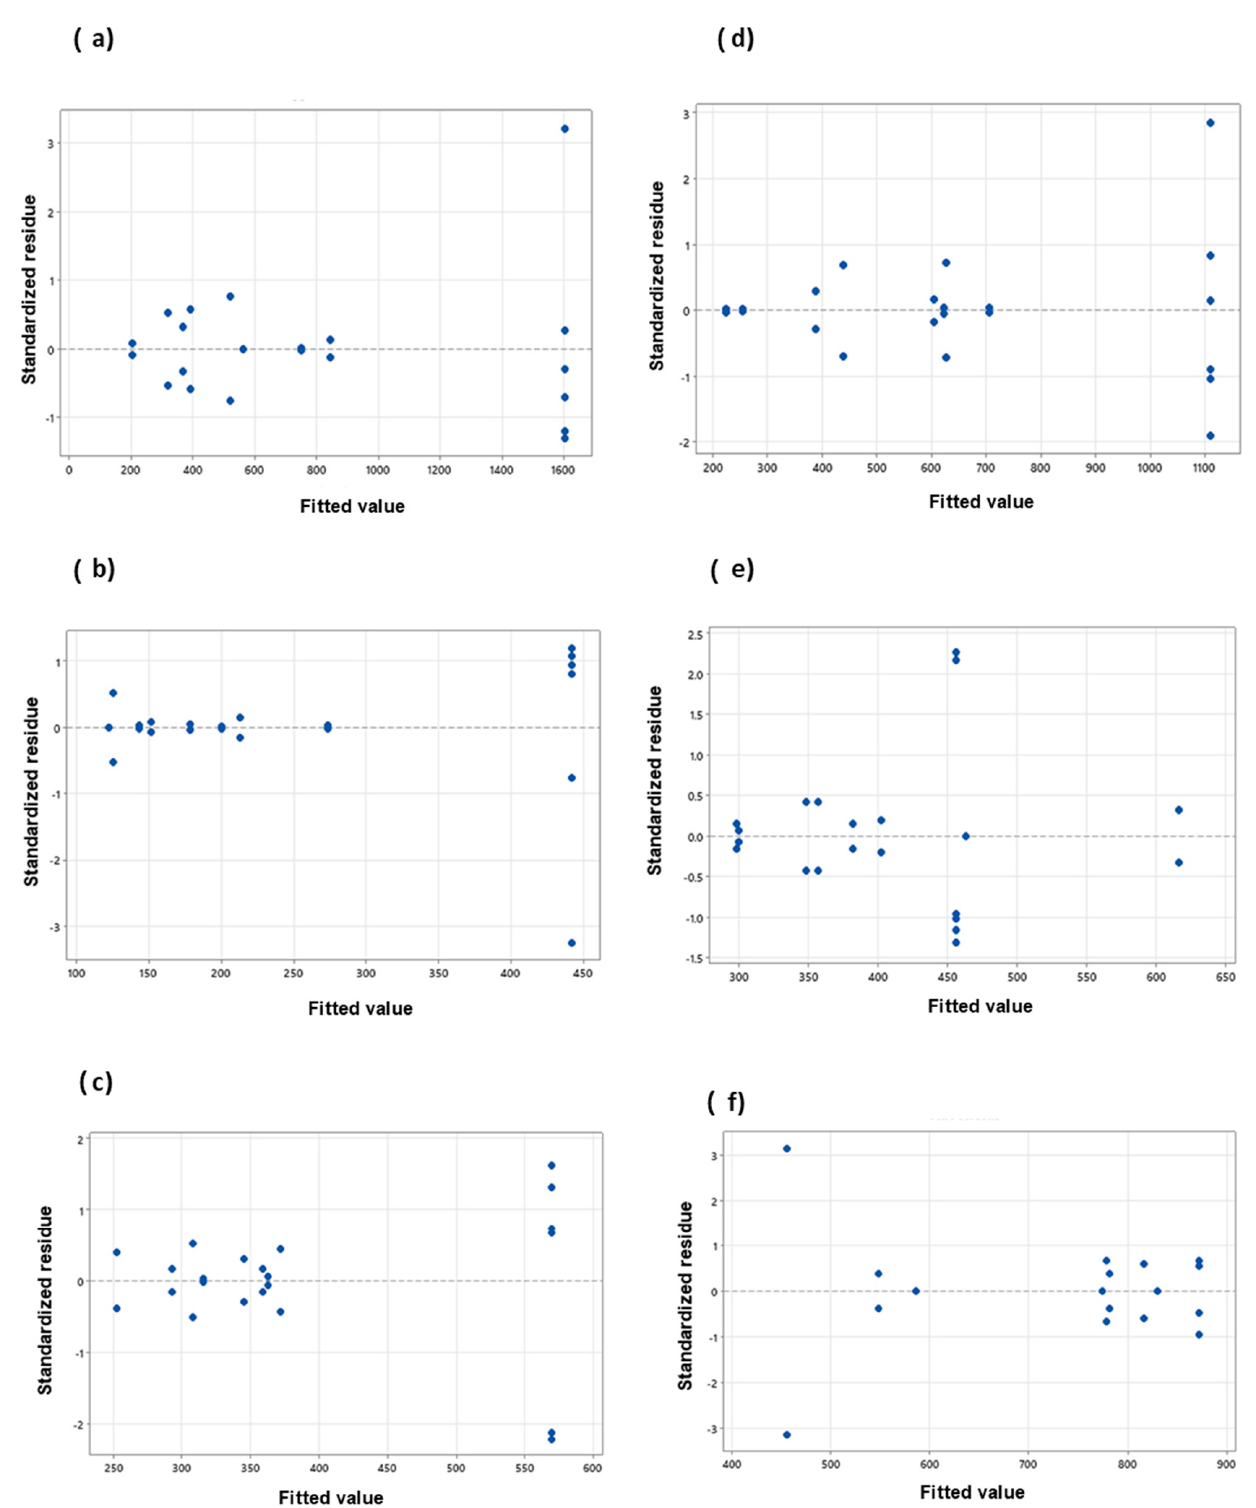
Figure 4. Standardized residues vs. fitted values plot for polyphenols (left) and flavonoids (right) contents; ( a , d ) peel; ( b , e ) endocarp and ( c , f ) kernel.